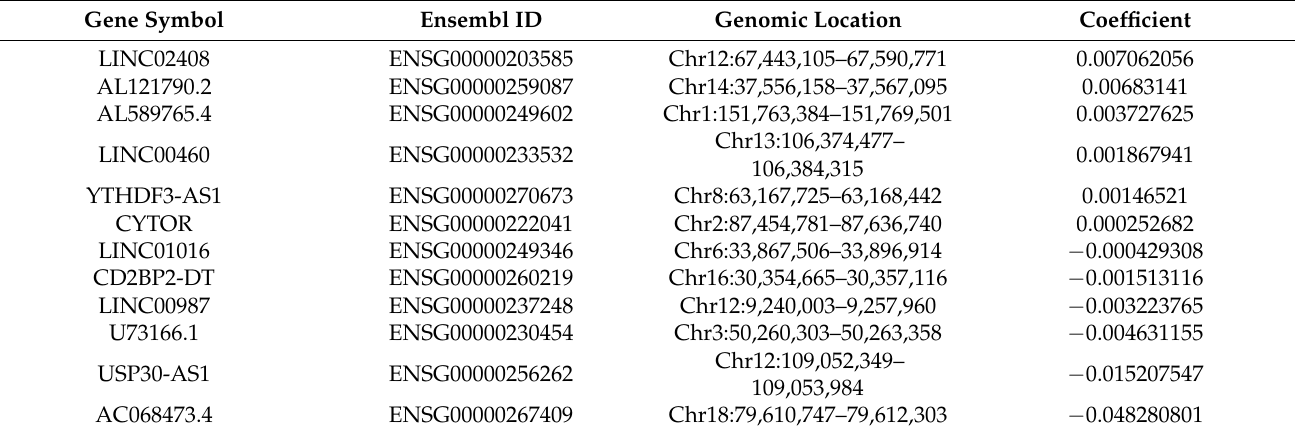
Table 1. The coefficients of 12 RBP-related lncRNAs based on the multivariable Cox regression analysis in the training